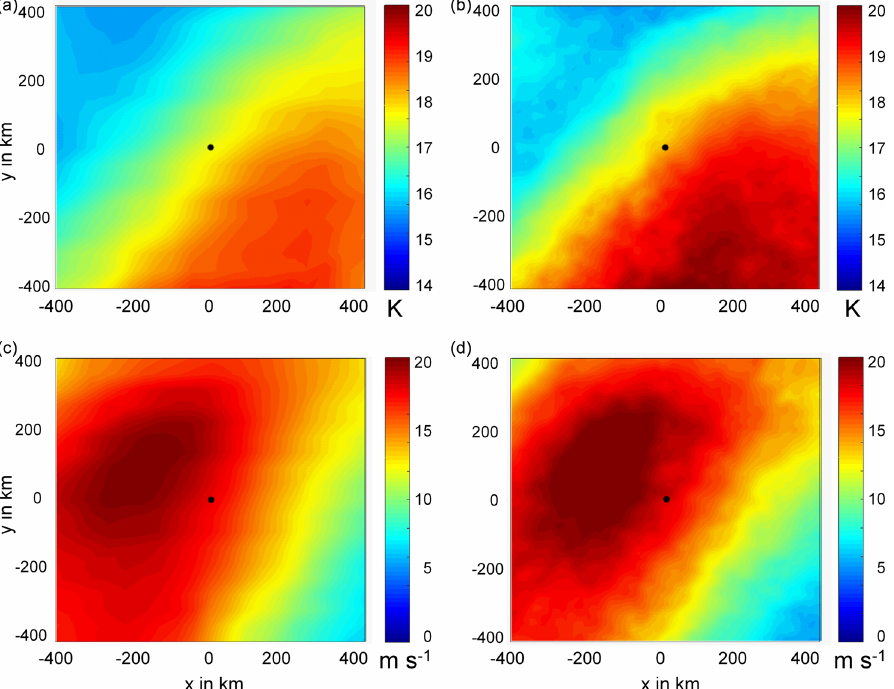
Figure 11. Composites of LR (a, b) and DLS (c, d) for hail diameters D ≥ 5cm and track lengths L ≥ 100km based on ERA-Interim (a, c) and coastDat-3 (b, d) reanalyses.